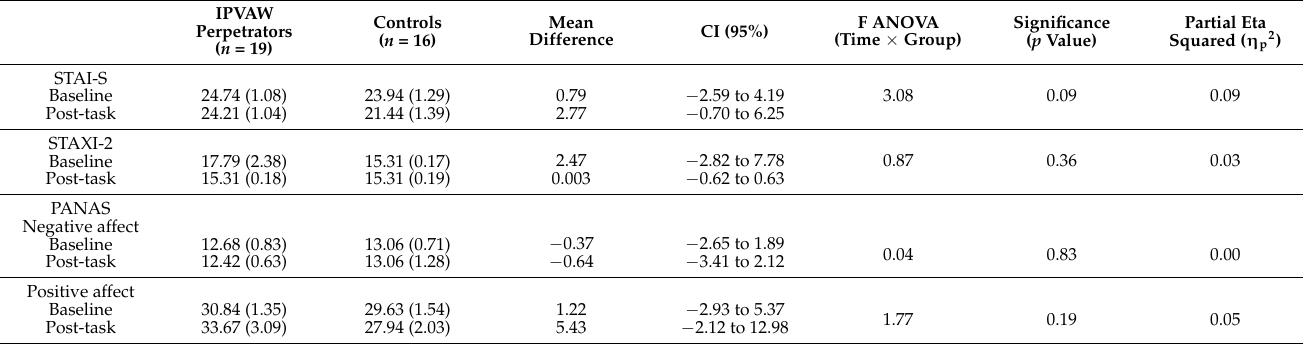
Table 3. Means and Standard Error of the Mean for Hormones and Psychological state variables in Each